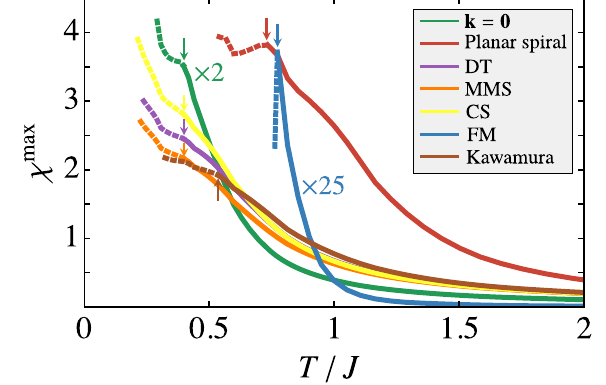
FIG. 21. RG flows of the spin susceptibility for S ¼ 1 = 2 at the ordering wave vectors of the seven magnetically ordered phases evaluated at the data points marked by black disks in Fig. 16(a). The points at which the solid lines become dashed (marked by arrows) indicate an instability in the flow, indicating an onset of magnetic order.